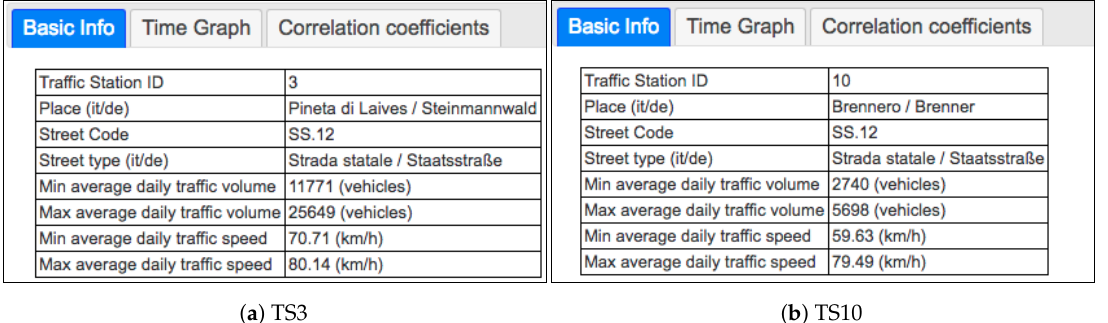
Figure 8. The basic information of selected traffic stations in January